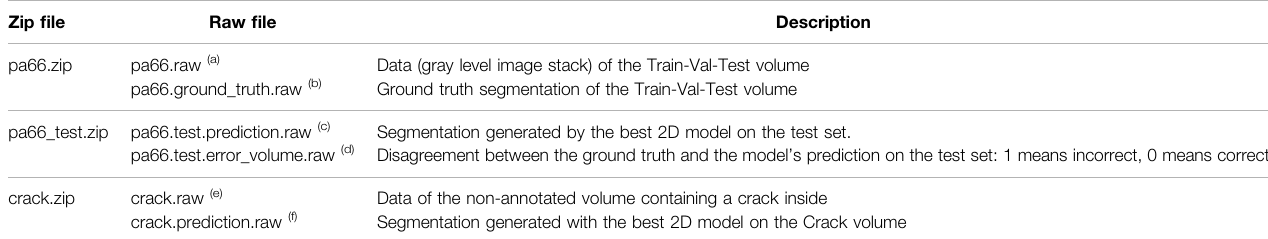
TABLE4| Published3Dvolumes:allthedatanecessarytotrainandtestthemodelspresentedinthispaperarepubliclyavailableonZenodo(Bertoldoetal.,2021a).Theraw fi leshavecomplementaryraw.info fi lescontainingmetadata(volumedimensionsanddatatype)aboutitsrespectivevolume.Noticethatthevolumes(a)and(b)containall thethreesplits(train,validation,test)together(1900z-slices),whilethevolumes(c)and(d)correspondtotheirlast300z-slices.Ademoofhowtoreadthedataisavailableon GitHub. The values inthe data volumes are integersfrom 0 to255, where the former isblack and thelatter iswhite. The values in thesegmentation volumes (predictions and ground truth) are 0, 1, and 2, which respectively correspond to the phases matrix, fi ber, and porosity. The volumes (e) and (f) correspond to the volume in Figures 5 , 6 . Figure3 wasgeneratedinFiji(Schindelinetal.,2012)withthevolume(a). Figure4 wasgeneratedinAvizowithvolumes(a)and(d),whichisderivedfromvolumes(b)and (c). Figure 6 was generated in Avizo with volumes (e) and (f). Zip fi le Raw fi